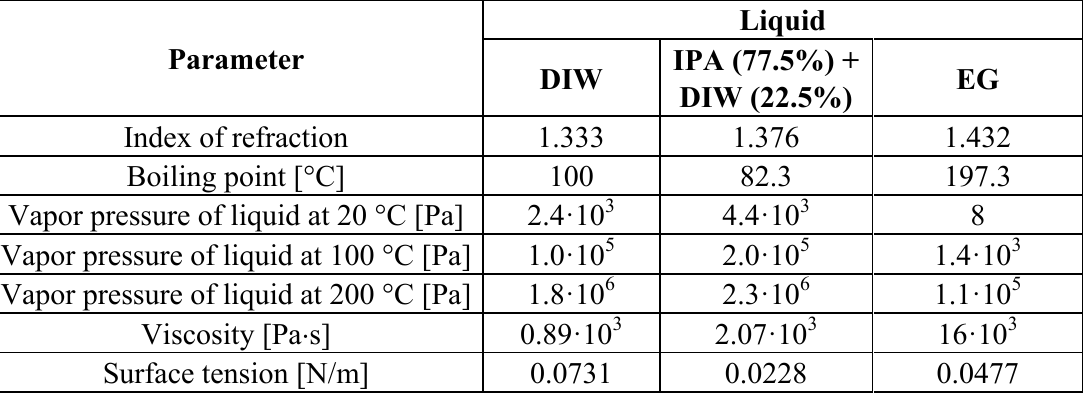
Table 1. Parameters of liquids: Water–DIW, Isopropyl alcohol –IPA, Ethylene